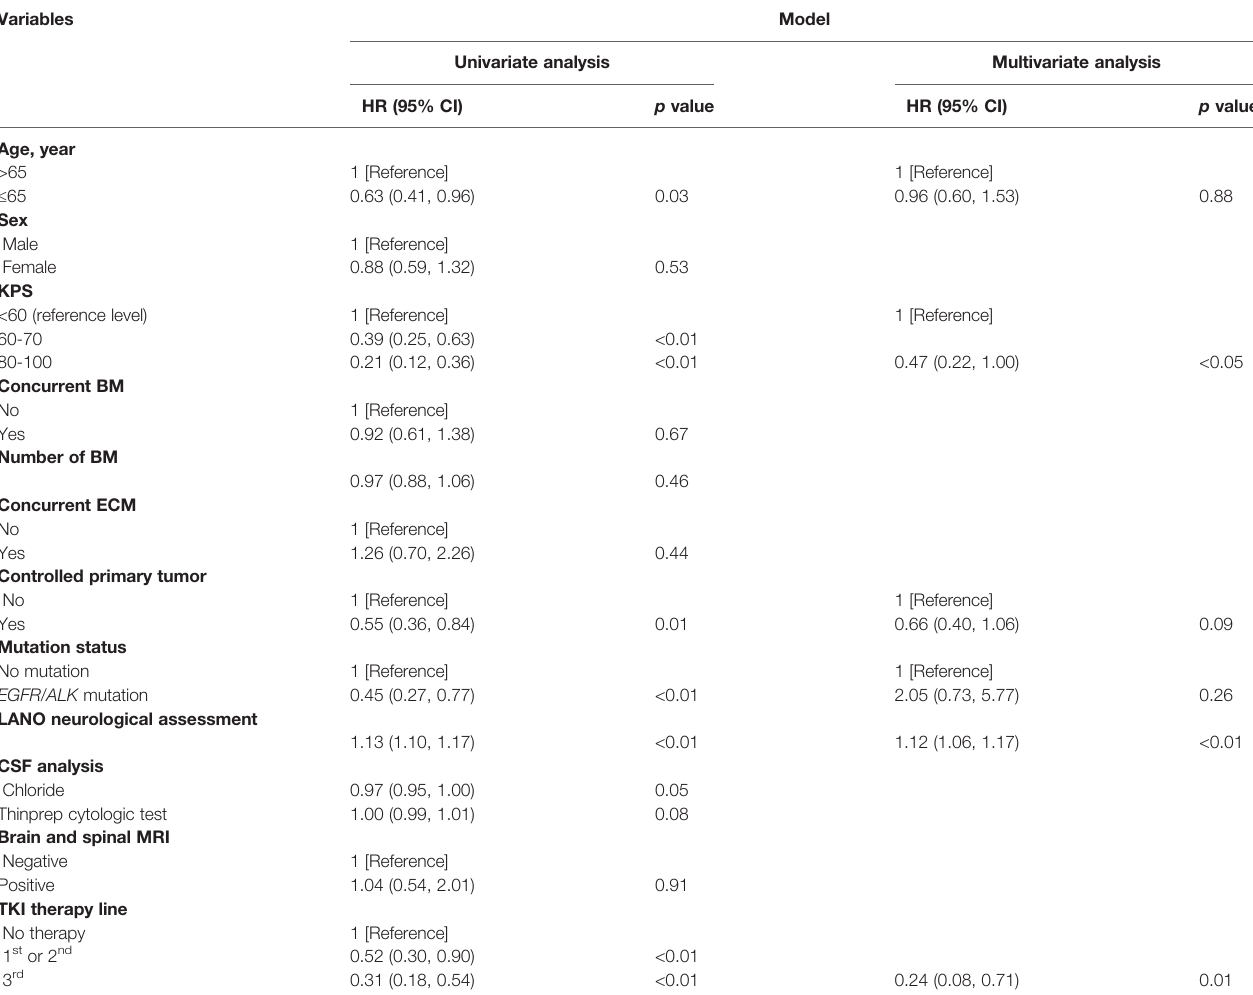
TABLE 2 | Univariate and multivariate Cox regression analysis of overall survival of the training set.